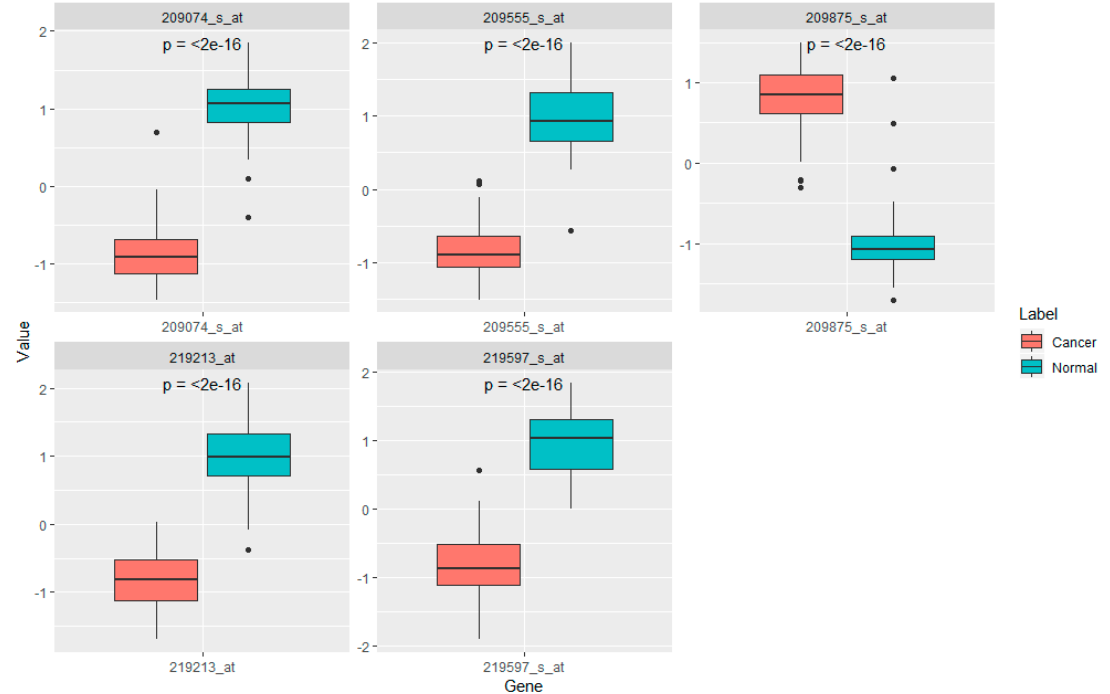
Figure 6. Boxplots of differential expression level between normal and lung samples on five genes from SIS-LASSO, SIS-MCP, and SIS-SCAD with the ranked data. Each boxplot contains the p-value of mean differential expression between two groups with a two- sample t-test.